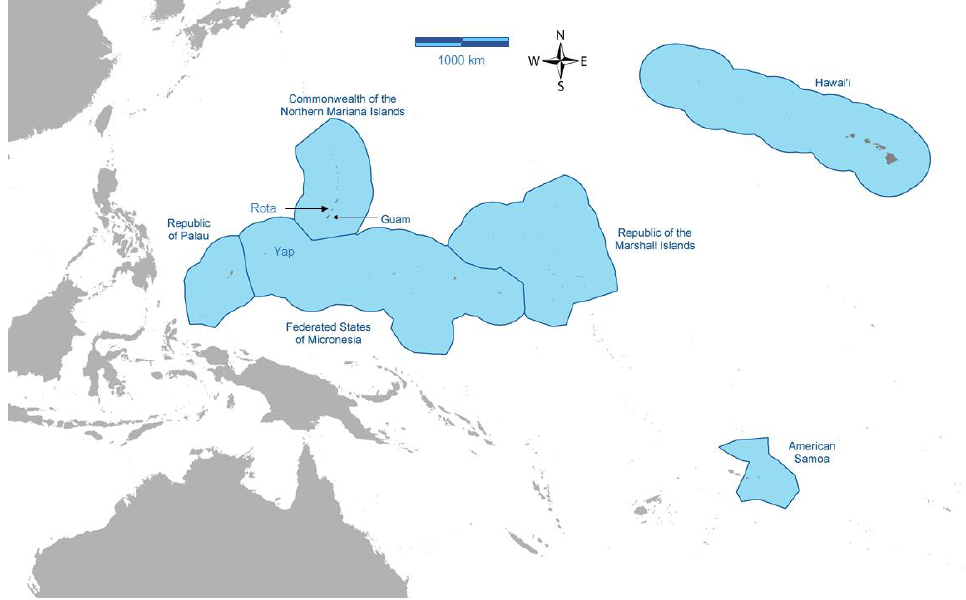
Figure 1. Map of the American-affiliated Pacific Islands of Micronesia, including Guam, Yap, and Rota. Reproduced by permission from Pacific RISA, US National Oceanic and Atmospheric Administration, pacificrisa.org.